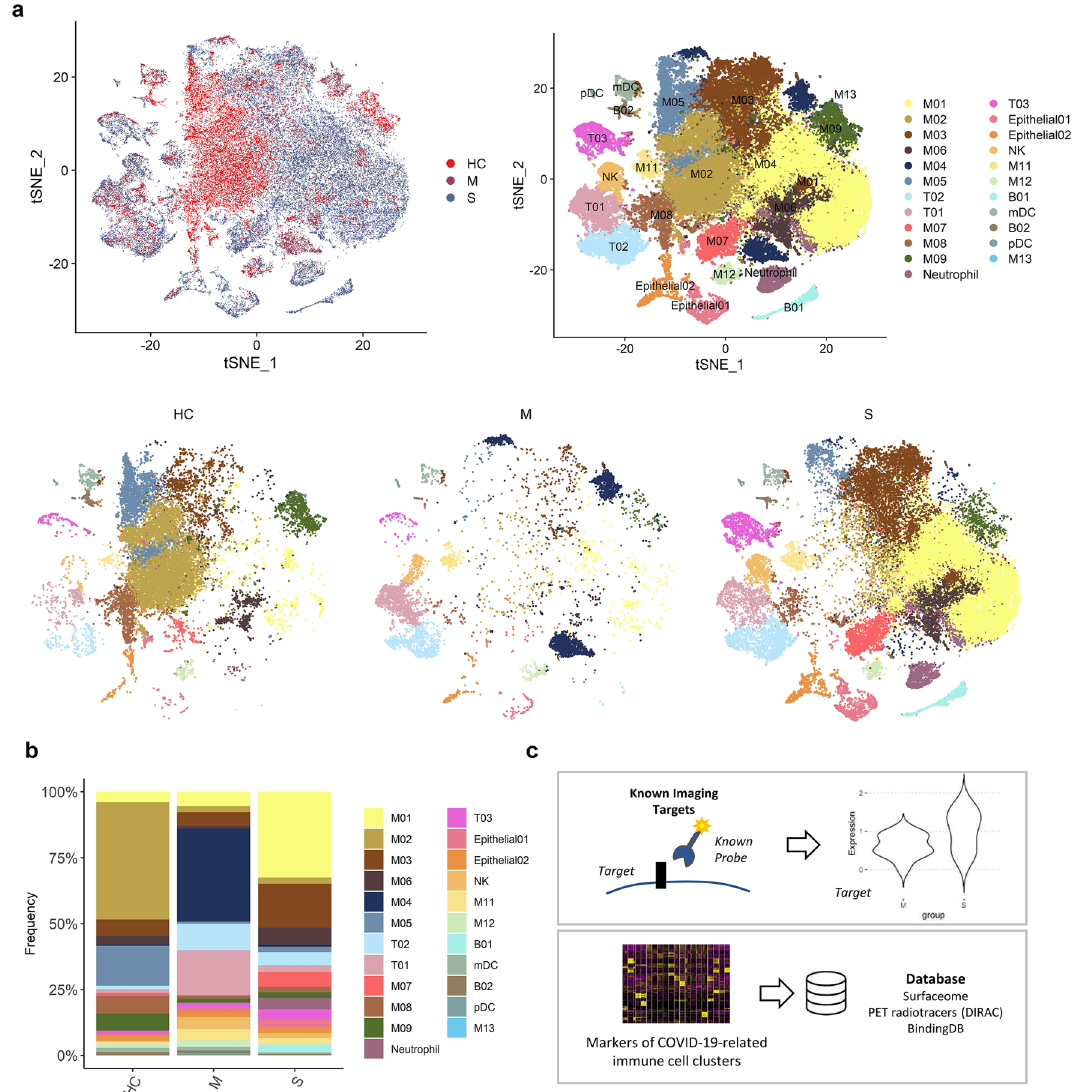
Figure 1. Bronchoalveolar immune landscape of COVID-19 patients and overview of the study design. (a) t-SNE projection of major cell type clusters in BAL fluid according to the severity of COVID-19 infection. Each point represents a single cell, and color coding of each patient group ( upper left ) and cell type population ( upper right ) are shown adjacent (HC = healthy control; M = moderate COVID-19 infection; S = severe COVID- 19 infection) . (b) The composition of major cell types per patient group. (c) Workflow for targetable molecule discovery in severe COVID-19 patients. We analyzed the expression level of potential imaging targets for COVID-19 patients. Additionally, we explored the marker genes of COVID-19-related immune cell clusters from three public databases (Surfaceome database, PET tracer database, and 19 patients 27 . The latter dataset contains scRNA-seq of peripheral blood mononuclear cells (PMBCs) from four healthy donors, five influenza patients, and eight COVID-19 patients 28 . Among the latter dataset, scRNA-seq from healthy donors and COVID-19 patients were selected. Pre-processing was performed in the same way as described above, except that the resolution was set to 0.3. The resolution was set as lower value to obtain appro- priate number of clusters to characterize each cluster. In the former dataset, six markers were used to cluster immune cells and epithelial cells: CD68, FCGR3B, KLRD1, CD3D, KRT7, and TPPP3 (Supplementary Fig. S2a). In the latter dataset, six markers were used to cluster immune cells, platelet, and erythrocyte: CD68, CD6, HBB, KLRD1, PPBP, and MS4A1 (Supplementary Fig. S3a). Expression of candidate proteins for imaging and thera- peutic targets were evaluated in each dataset. All statistical analyses were performed using the R program (v 3.6.1).